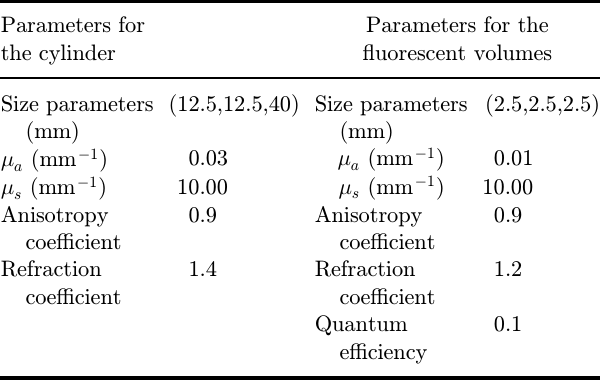
Table 1. Parameters of the normal